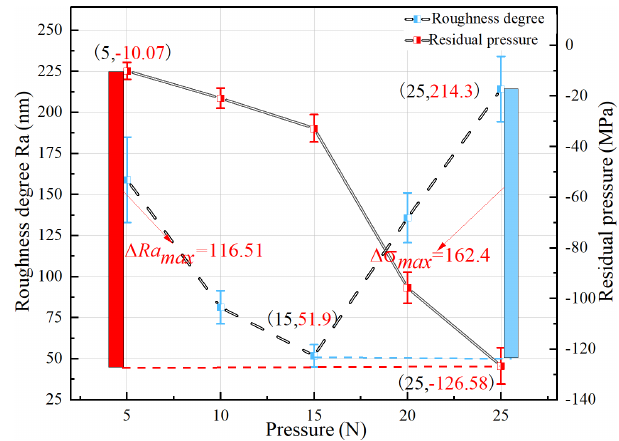
Figure 7. Relationship between pressure and surface roughness and residual stress.